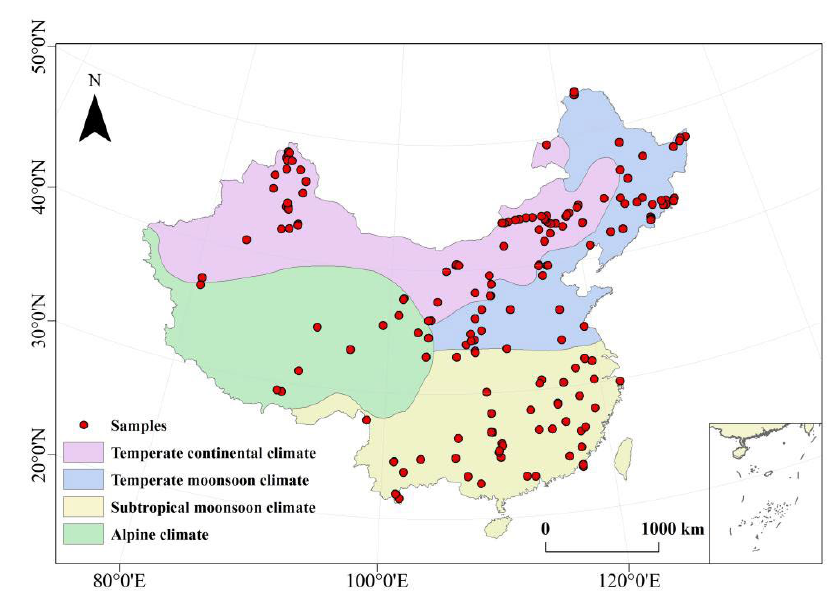
Figure 1. Distribution of observed specific leaf area (SLA) data in China.